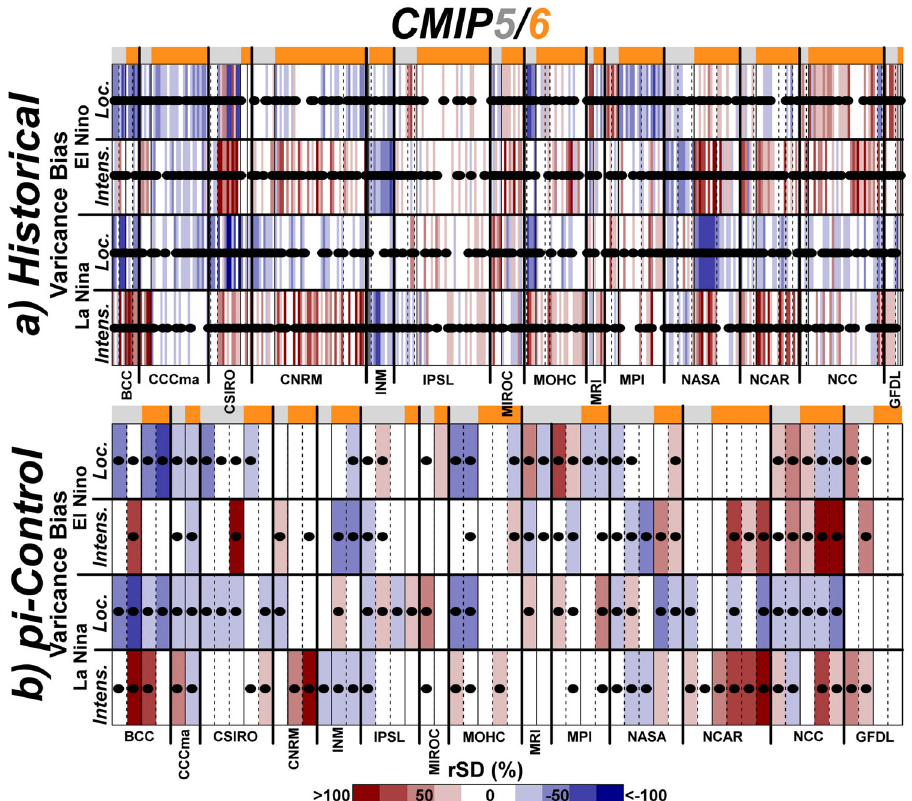
Fig. 5 CMIP5/6 bias in decadal variability of ENSO ’ s most likely location and intensity. a Average ratio of standard deviation (rSD) between historical runs and observed decadal variance (>10 years) in the running 10-year most likely location and intensity of El Niño and La Niña events. b Same as ( a ) but using pi-Control runs. Statistical signi fi cance is assessed by performing a two-sided Fisher ’ s F -test at p = 0.05 between every 100-yr segments through the course of climate simulations and every 100-yr segments in the four longer-term observational SST datasets (i.e., 27,740 ≤ n ≤ 209,000 replicates), to quantify a rate of success (i.e., the number of times observations and simulations showed equal variance). Black dots highlight simulations for which the rate of success is lower than